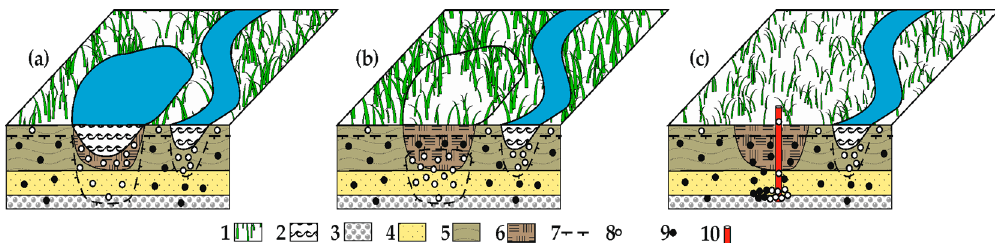
Figure 7. Paleoenvironmental reconstruction of the sequence at Kolyma floodplain disclosed by borehole 3,4-07. ( a ) Soils of the thaw bulb under the floodplain lake with potential methane production; ( b ) Freezing of the methane-enriched soils of a thaw bulb after the lake drainage; ( c ) Methane trapped in the pores and cavities of permafrost after complete freezing of the thaw bulb. Key: 1, floodplain wetland; 2, warm riverine and lacustrine waters; 3, riverine alluvium, gravel layer; 4, riverine alluvium, sand layer; 5, floodplain alluvium, silt layer; 6, lacustrine deposits, peaty silts; 7, permafrost table; 8, free methane; 9, trapped methane; 10, borehole.